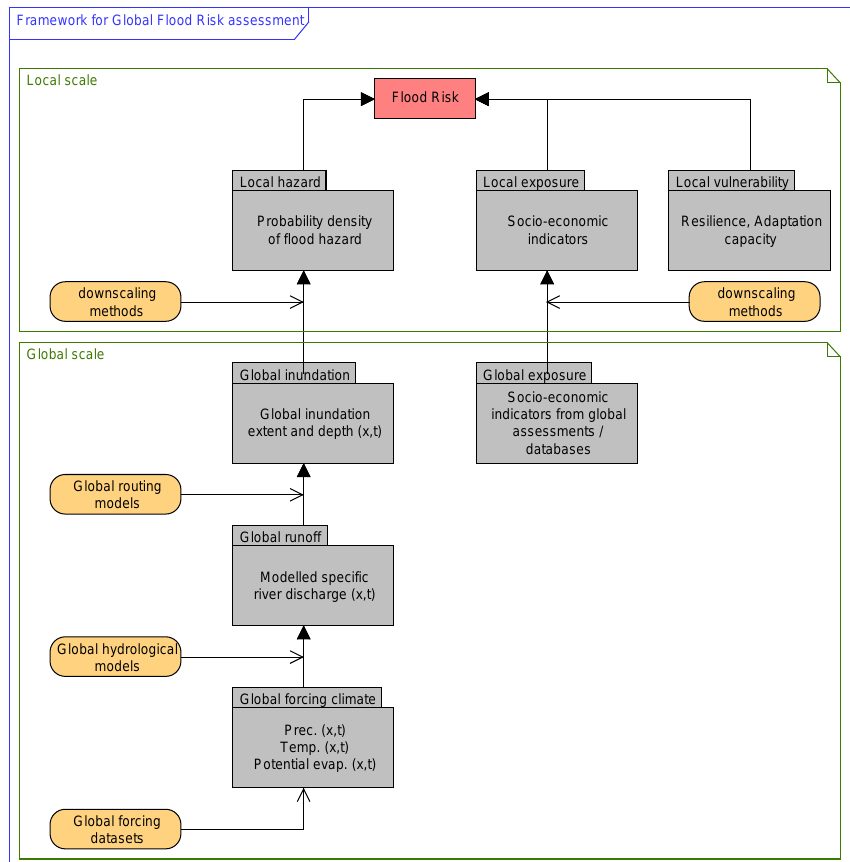
Fig. 1. Schematic of framework for global flood risk